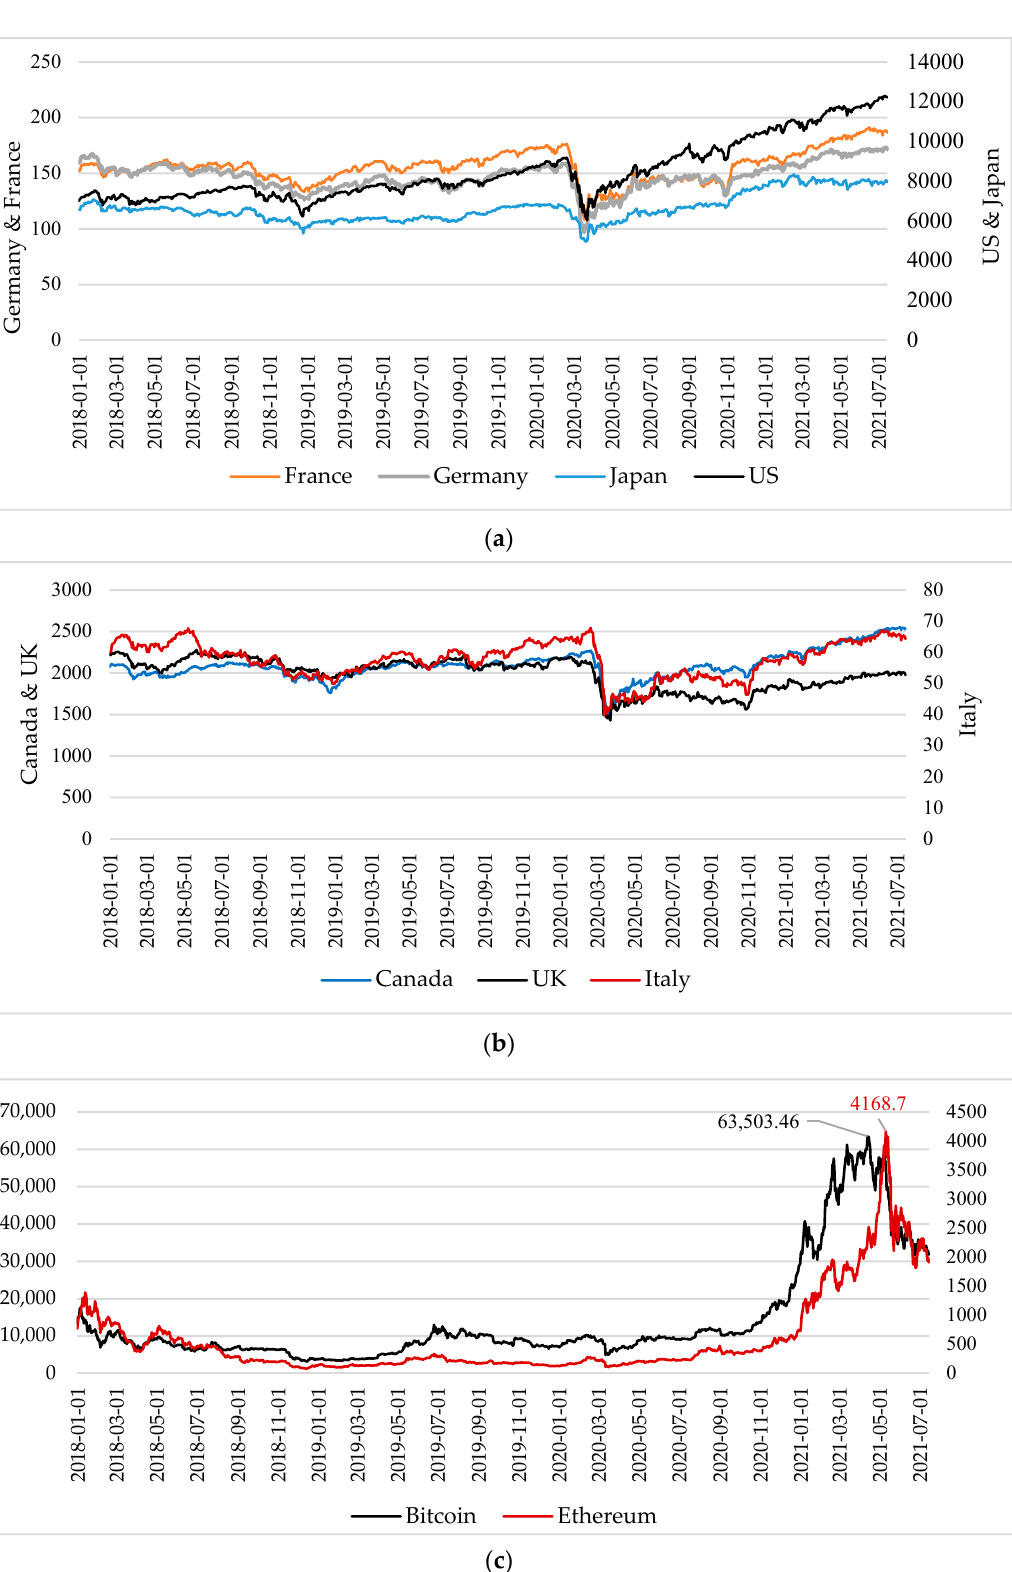
Figure A1. G7 MSCI Stock Market Index and Cryptocurrency Prices (in US$); ( a ) Japan, France, Germany, and US; ( b ) Canada, Italy, and UK; ( c ) Bitcoin and Ethereum.